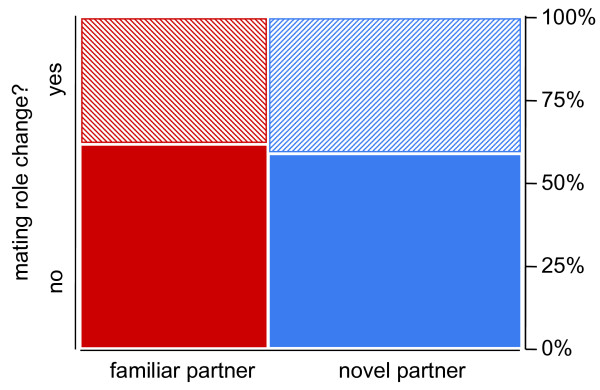
Mating role changes between a focal snails' first and second mating. The mosaic plot shows the proportion of focal individuals switching roles split between 'familiar partner' (n = 29) and 'novel partner' (n = 39) treatment.